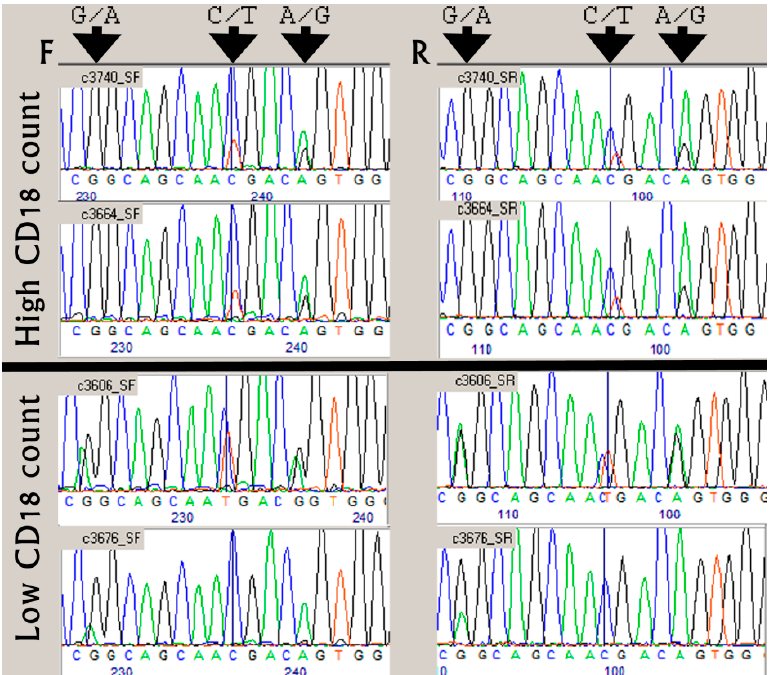
Figure 2. Gene network of the ITGB2 (CD18) gene. Connections between nodes were based on protein–protein interaction data, predicted functional relationships between genes, and gene-pathway data produced by the GeneMANIA system using ITGB2 as the input gene and the Homo sapiens database. On the output of this prediction server, next to the gene nodes, the orthologous bovine autosome numbers and positions were annotated. The nodes of genes with positions coinciding with BTA3 are highlighted in green.